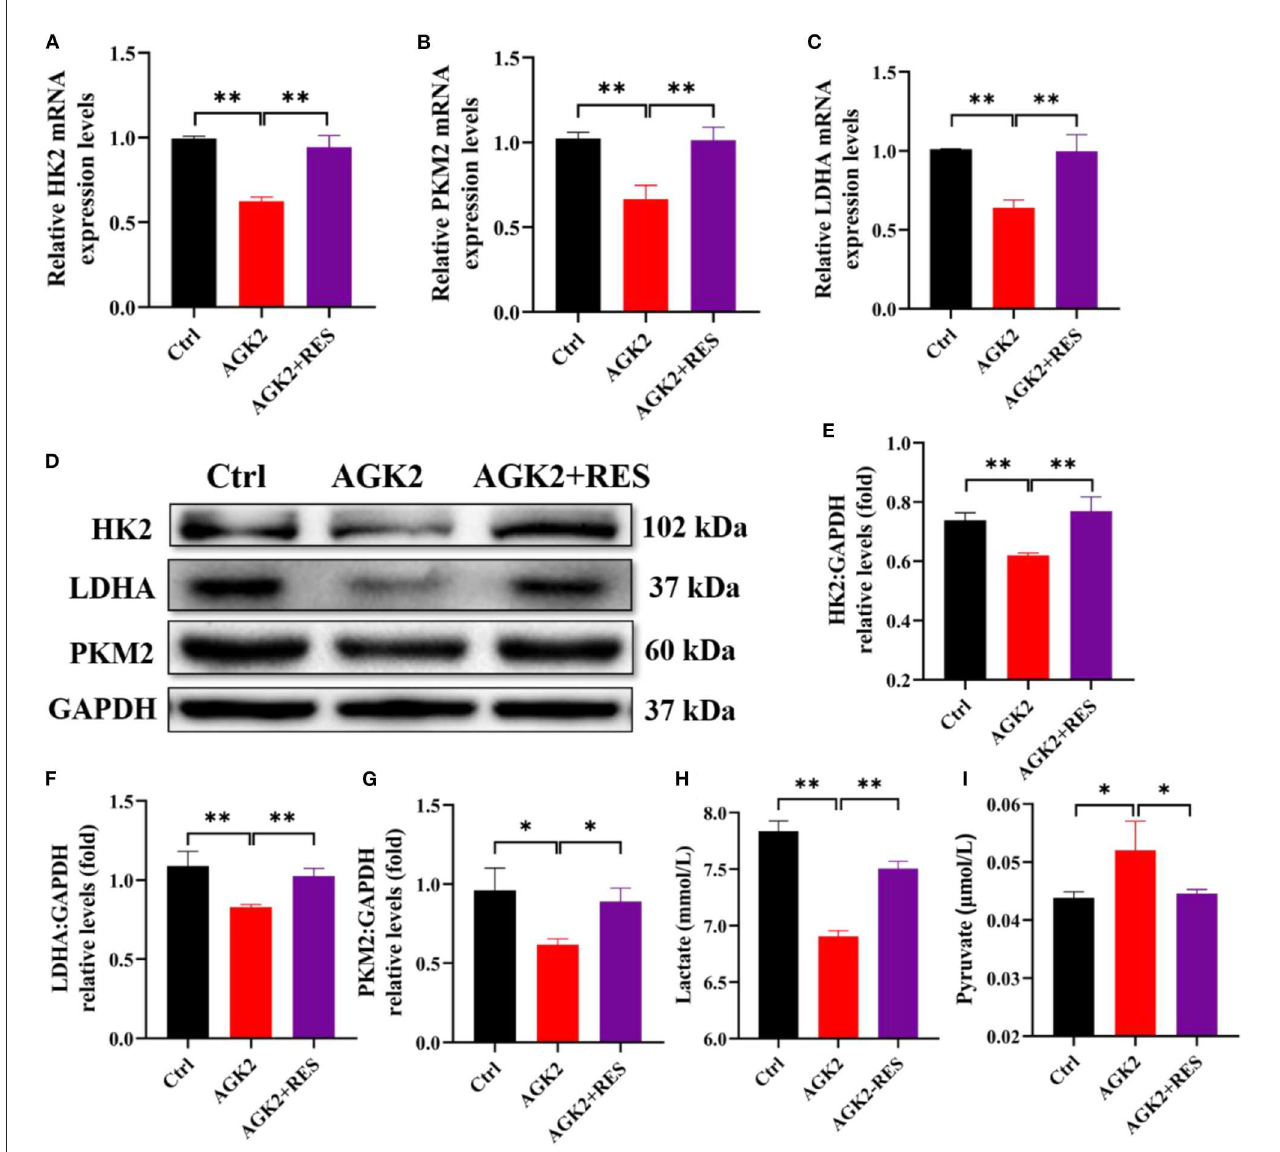
FIGURE5 RES can upregulate the expression of SIRT2 in KGN cells treated with insulin and AGK2. The relative mRNA expression levels of HK2 (A) , PKM2 (B) , and LDHA (C) in KGN cells were determined using qPCR. The protein levels of HK2, LDHA, and PKM2 were determined by Western blot (D) and quantified by ImageJ software (E–G) . The levels of lactate and pyruvate in KGN cells using ELISA (H, I) . Significant differences between the groups are shown as * P < 0.05 and ** P <